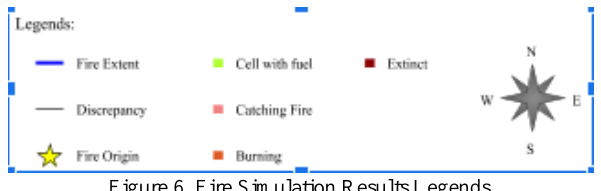
Figure 6. Fire Simulation Results Legends